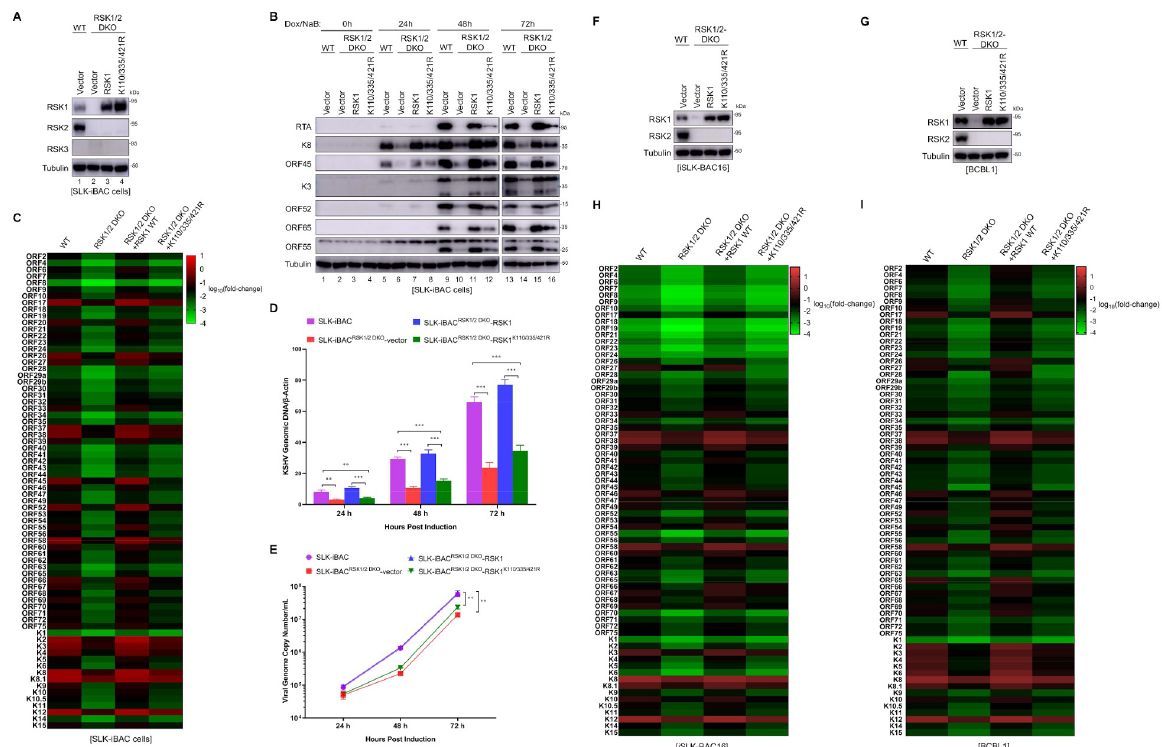
Fig 3. RSK1 SUMOylation is required for efficient KSHV lytic replication. ( A ) Generation of SLK-iBAC RSK1/2 DKO , SLK-iBAC RSK1/2 DKO - RSK1 or SLK-iBAC RSK1/2 DKO -RSK1 K110/335/421R cells by CRISPR-Cas9 and lentivirus-mediated stable expression. ( B-C ) RSK1 SUMOylation affects viral protein expression at both RNA and protein levels during KSHV lytic replication. Indicated cell lines were treated with doxycycline (2 μ g/ml) and sodium butyrate (1 mM) to induce KSHV lytic replication. Cell lysates were collected at indicated time points and subjected to IB with indicated antibodies (B). Indicated SLK-iBAC cell lines were induced with doxycycline and sodium butyrate for 72 h. Total RNA was extracted, reverse-transcribed into cDNA, and used for KSHV whole-genome qPCR array analysis. The Δ C T values for each primer set were calculated and converted to a heatmap using R (C). ( D-E ) RSK1 SUMOylation is required for efficient viral genomic DNA replication (D) as well as progeny virus production (E) during KSHV lytic replication. The cell lysates or culture medium containing progeny viruses were collected at indicated time point. Total DNA was isolated and viral genomic DNA was quantified by qPCR. ( F-G ) Generation of iSLK-BAC16 RSK1/2 DKO , iSLK-BAC16 RSK1/2 DKO -RSK1, iSLK-BAC16 RSK1/2 DKO -RSK1 K110/335/421R , BCBL1 RSK1/2 DKO , BCBL1 RSK1/2 DKO -RSK1, BCBL1 RSK1/2 DKO - RSK1 K110/335/421R cells by CRISPR-Cas9 and lentivirus-mediated stable expression. ( H-I ) RSK1 SUMOylation affects viral protein expression during KSHV lytic replication. iSLK-BAC16 related cell lines (H) were treated with doxycycline (2 μ g/ml) and sodium butyrate (1 mM) and BCBL1 related cell lines (I) were treated with TPA (20 ng/ml) to induce KSHV lytic replication. RNA samples were collected at 72 h post- induction and subjected to RT-qPCR analysis for overall KSHV gene expression. Heatmaps were generated using similar method as Fig 3C.